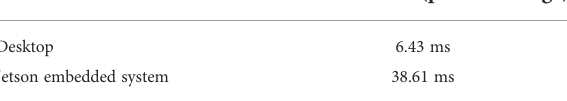
TABLE 7 Inference times of PSS-Net on desktop and Jetson embedded system.